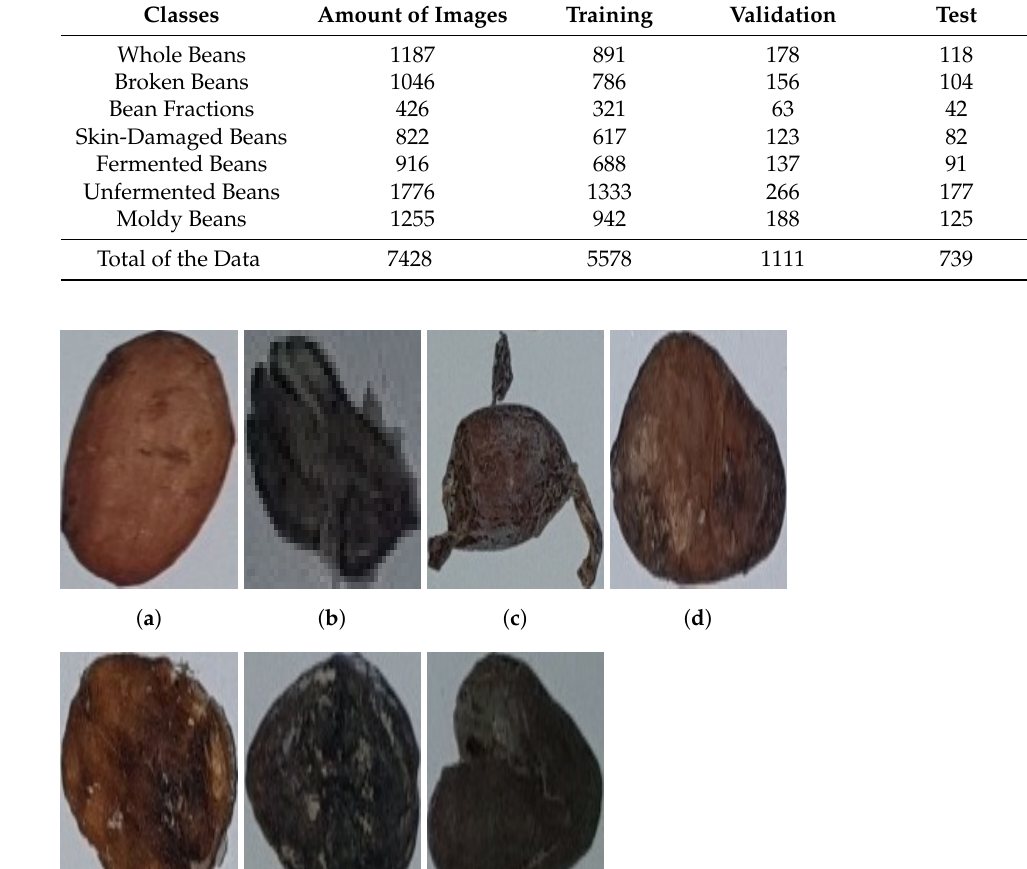
Table 1. Distribution Class of the Cocoa Bean Images.